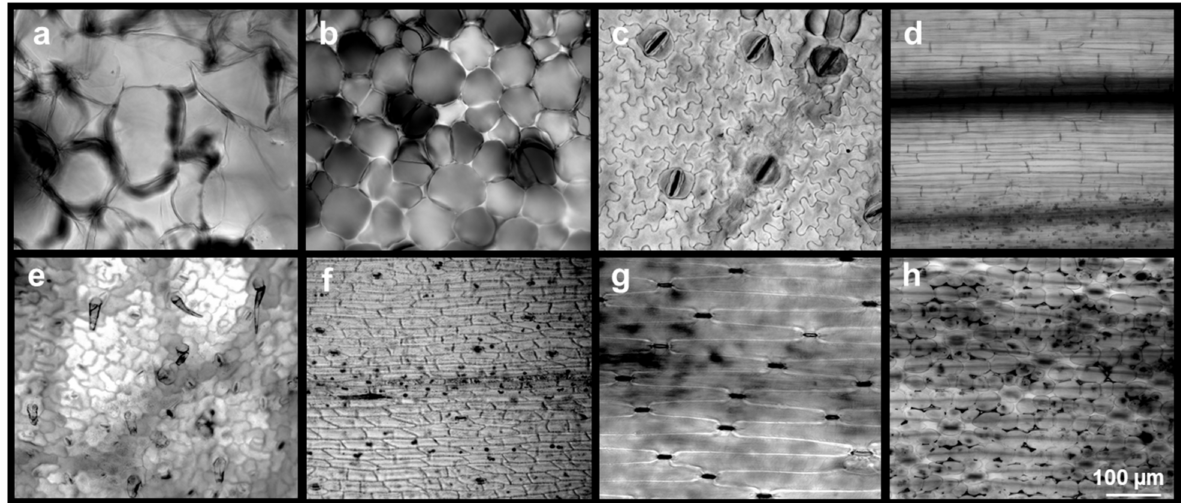
Figure 8. Decellularized vegetal scaffold topography. Each scaffold displays a different surface morphology, such as seen in the ( a ) apple hypanthium, ( b ) celery stalk, ( c ) aquatic plant leaf surface, ( d ) wheatgrass stem sheath, ( e ) hybrid cherry tomato plant leaf, or ( f ) curly parsley stem. Such topography can differ within a plant, as seen in the green onion’s leaf ( g ) exterior and ( h ) interior tissue. Data generated by authors for illustrative purposes for this